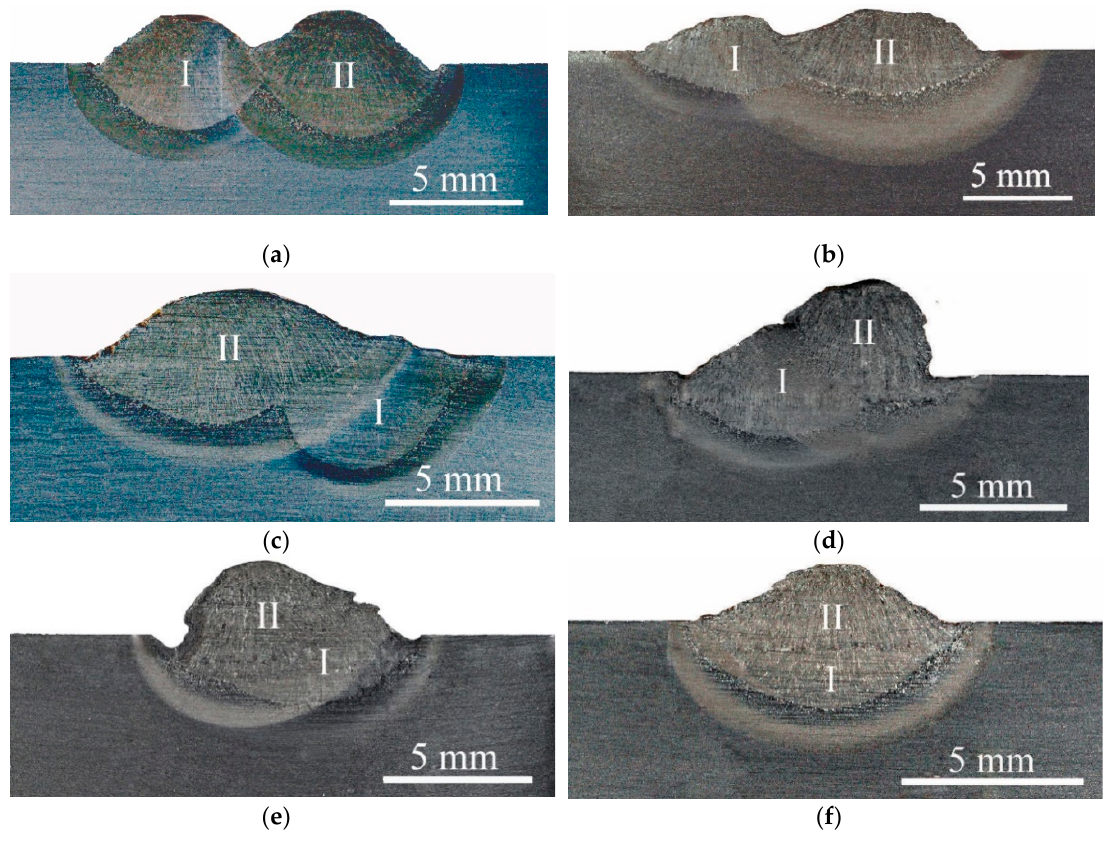
Figure 5. Results of the TBW macroscopic testing, I—first (tempered) bead, II—second (tempering) bead, ( a ) pitch 11%; ( b ) pitch 19%; ( c ) pitch 43%; ( d ) pitch 55%; ( e ) pitch 73%; ( f ) pitch 100%. Etch. Nital 4%.